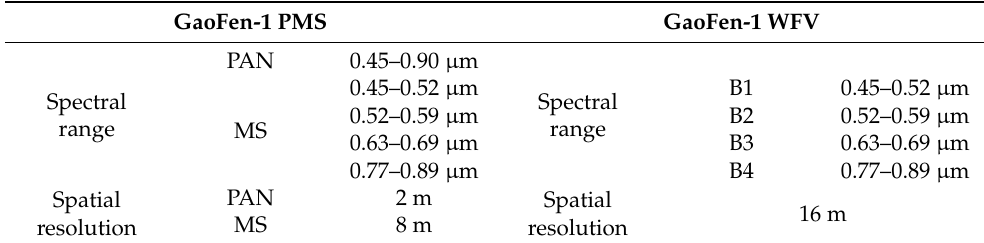
Table 2. GaoFen-1 spectral